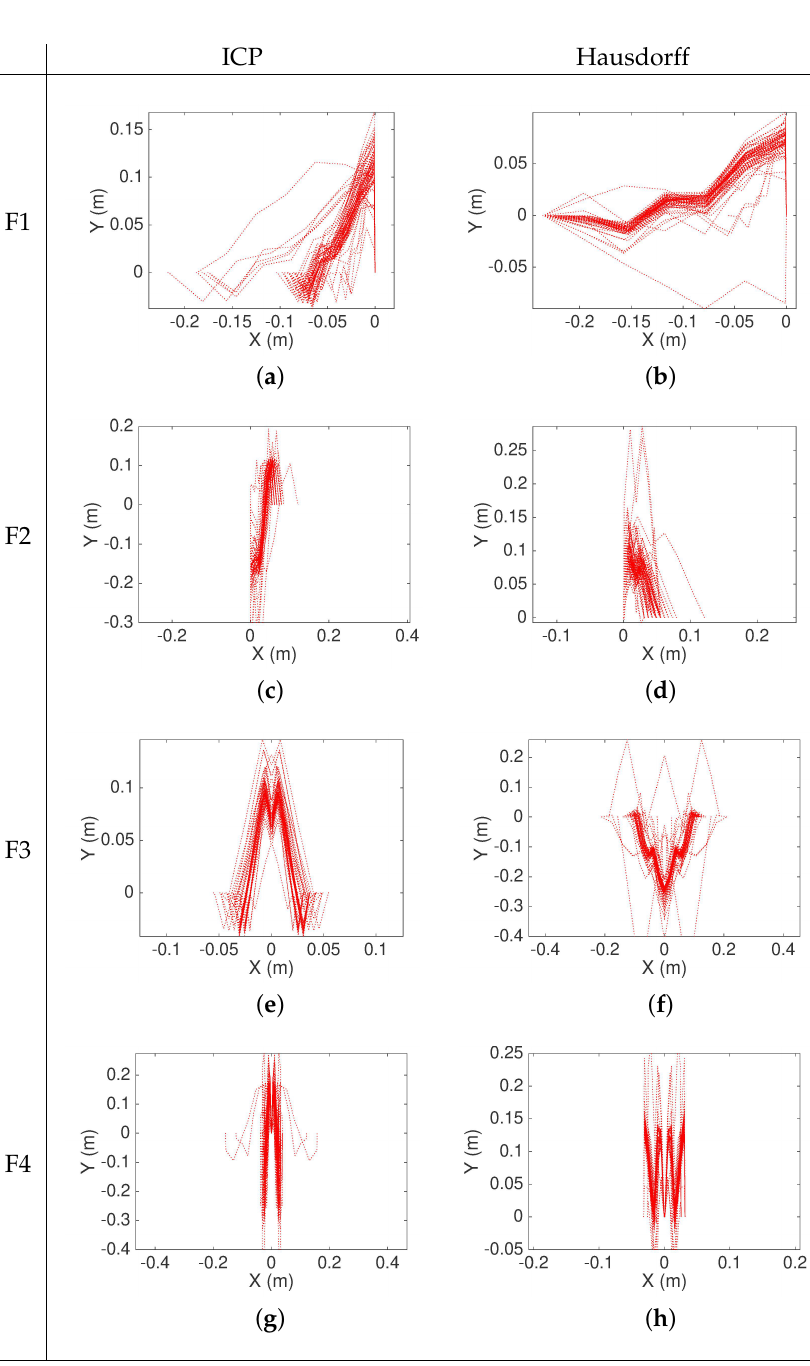
Figure 7. Optimized piecewise linear shapes found by the genetic algorithm after 45 iterations: F1—free ( a , b ); F2—inverted ( c , d ); F3—symmetric free shape ( e , f ); F4—symmetric inverted ( g , h ). The graphs show the evolution of multiple iterations superimposed showing the convergence to the optimized landmark